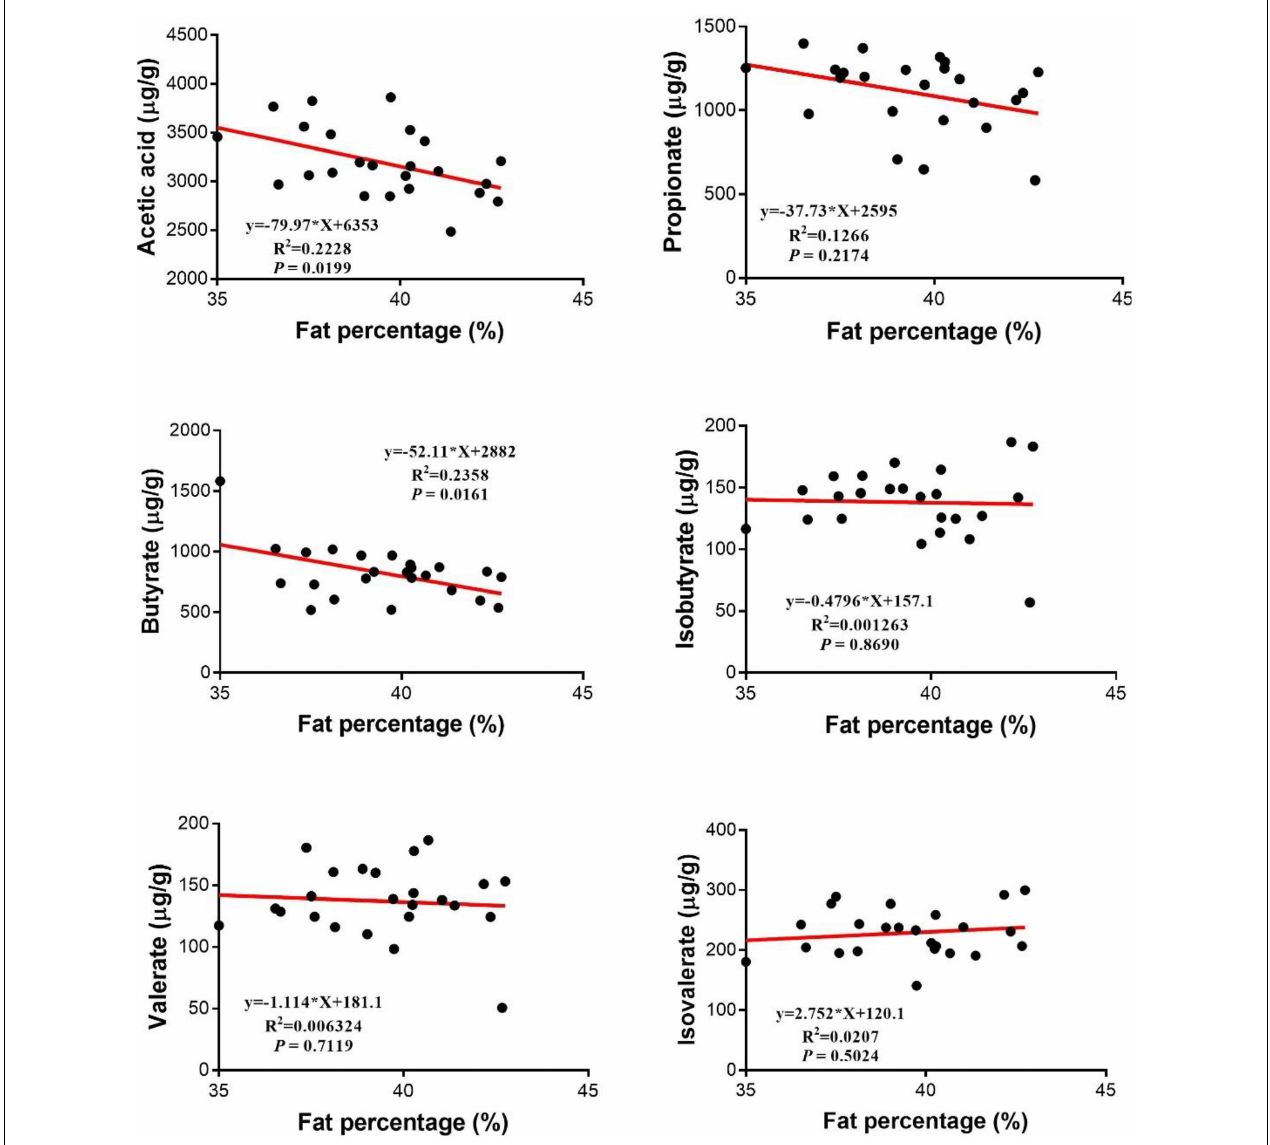
FIGURE 4 | Relationship between SCFAs and the fat percentage. Pearson correlations were used to determine the association between the fat percentage and colonic acetate, propionate, butyrate, valerate, isobutyrate, and isobutyrate concentrations.